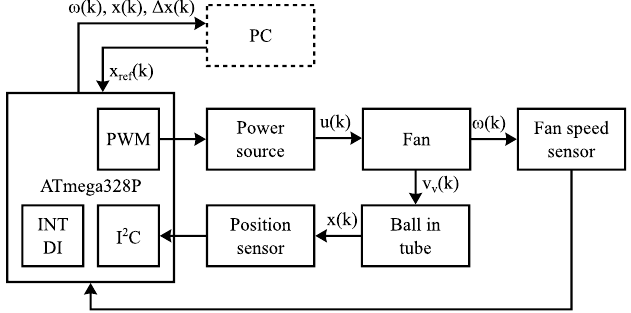
Figure 4. Diagram of subsystem interaction of Aerodynamic Ball Levitation